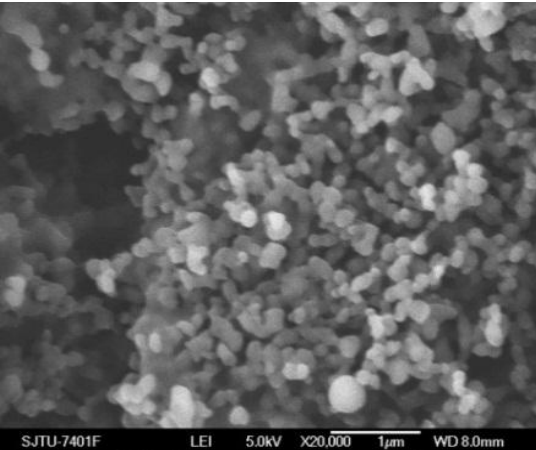
Figure 3. SEM images of nanoparticles prepared by SEDS process with different temperatures.